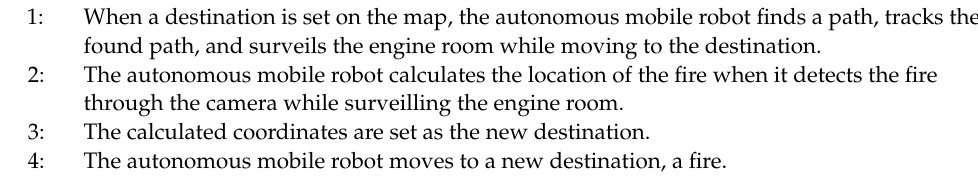
Figure 8. Detection result of fire (true positive). The purple squares are the fire detection bouding boxes. The last experiment was conducted in the ship’s engine room. It was difficult to experiment using fire or smoke in the engine room, so a banner was used. Algorithm 4 is the setting algorithm of the autonomous mobile robot during the experiment. Algorithm 4 Main steps of engine room experiment